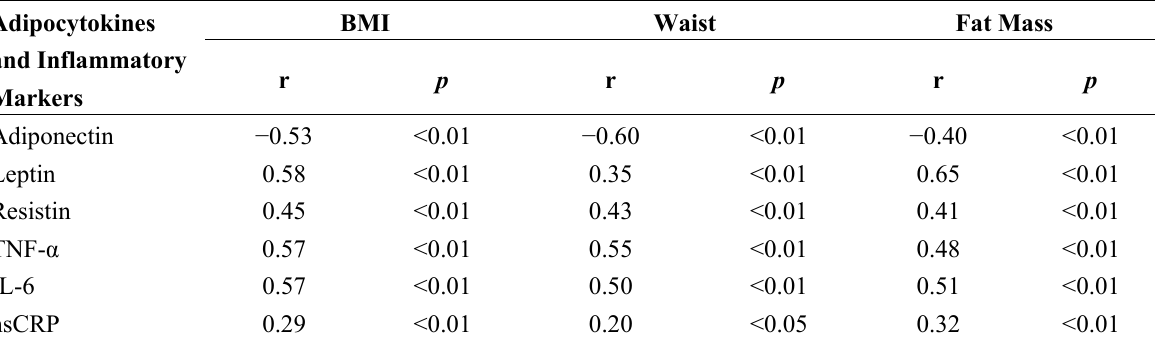
Table 2. Correlation between adipocytokines and inflammatory markers and parameters of obesity.